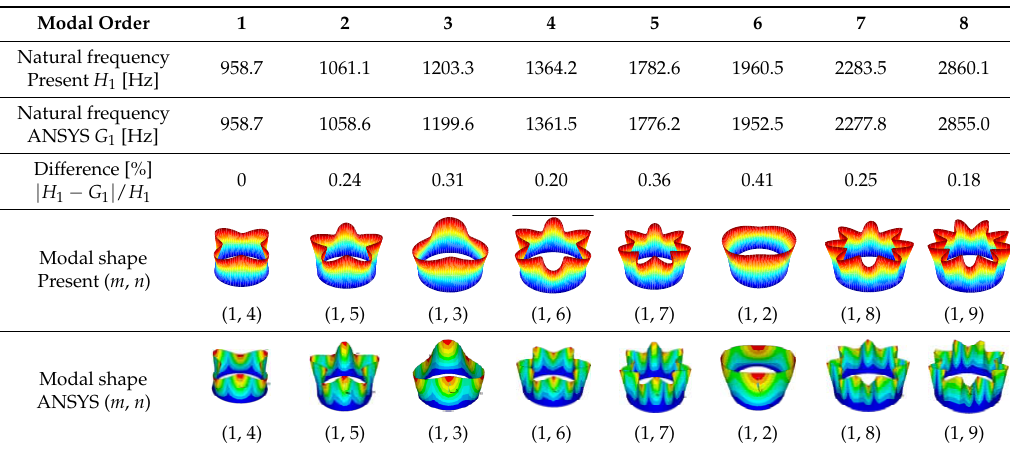
Table 4. The comparison of the first eight resonant responses of the FCTS obtained by theoretical calculations and the finite element method (mm).